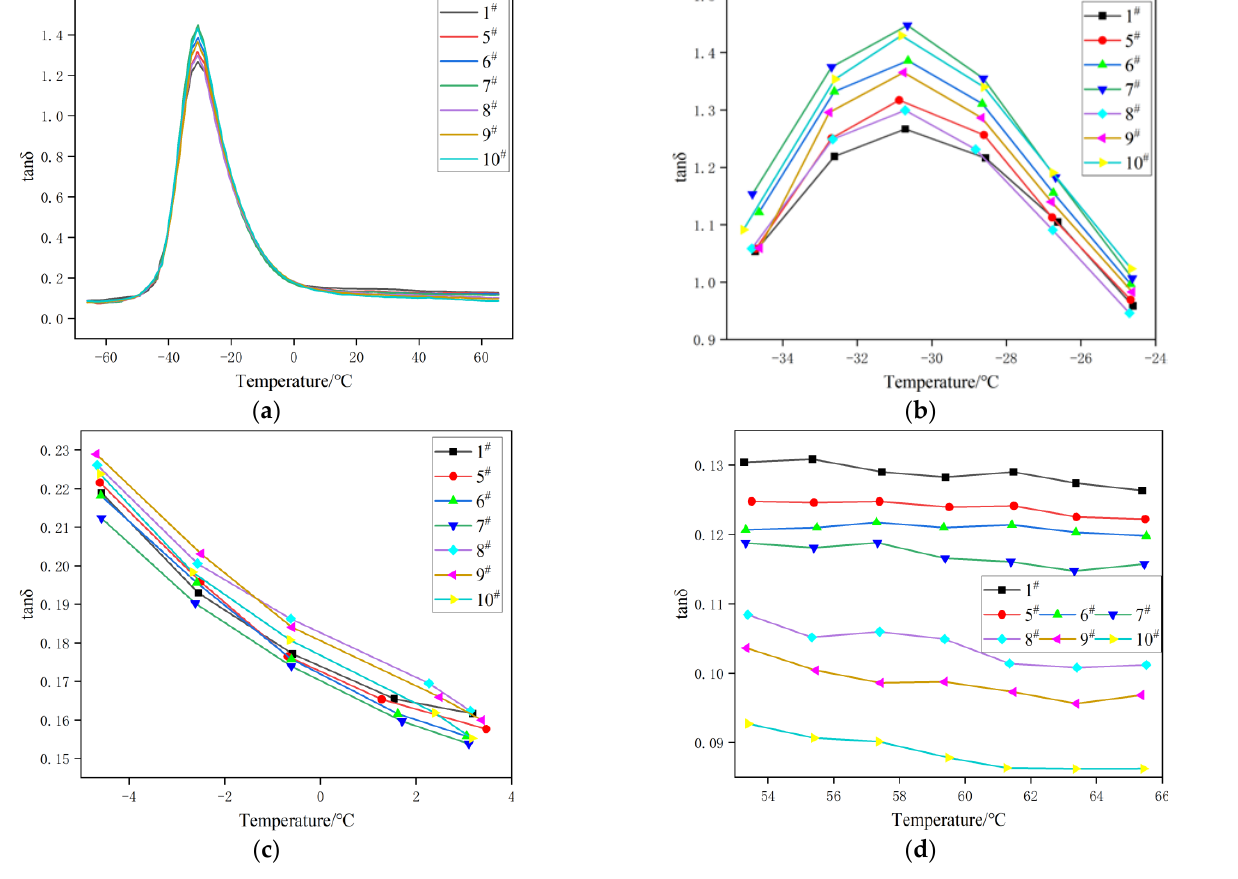
Figure 8. Dynamic mechanical properties of rubber composites.( a ) tanδ -T Curve of the composites; ( b ) is magnified graphs of curves around −30 °C; ( c ) is magnified graphs of curves around 0 °C; ( d ) is magnified graphs of curves around 60 °C .